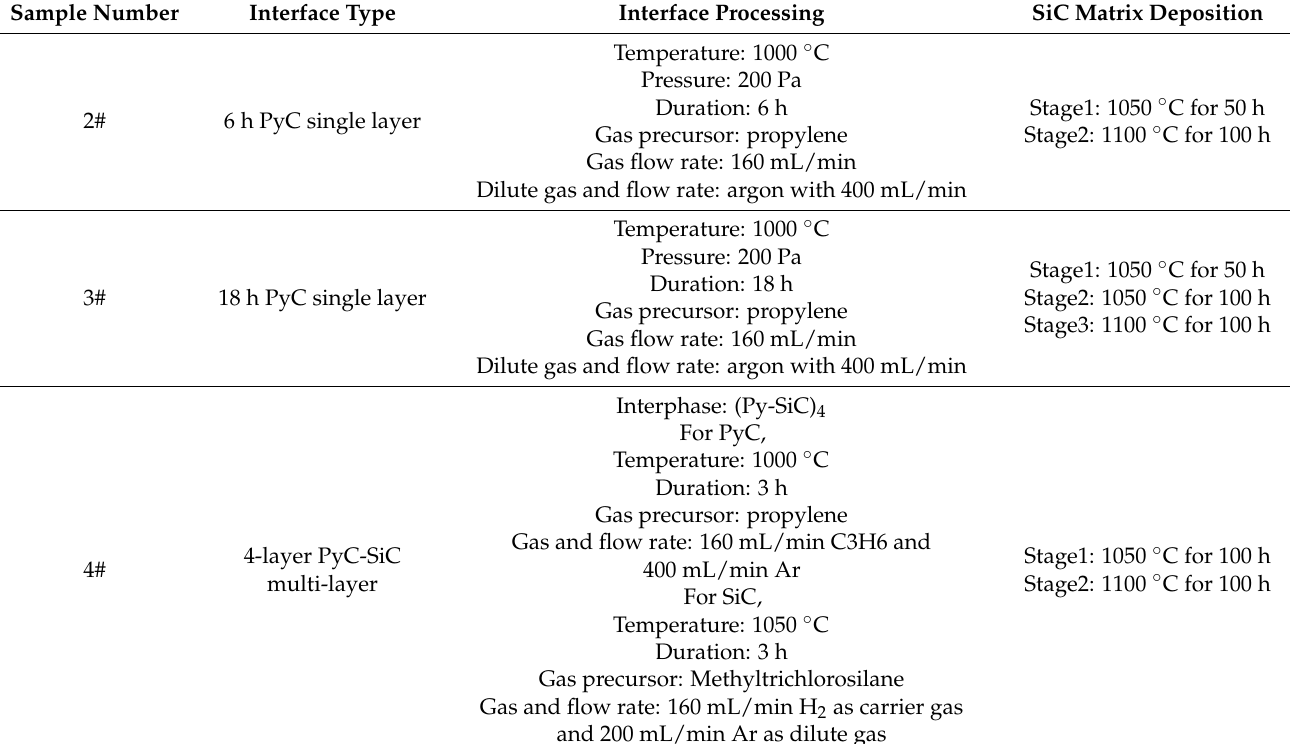
Table 2. The detailed processing parameters of the samples in each group.